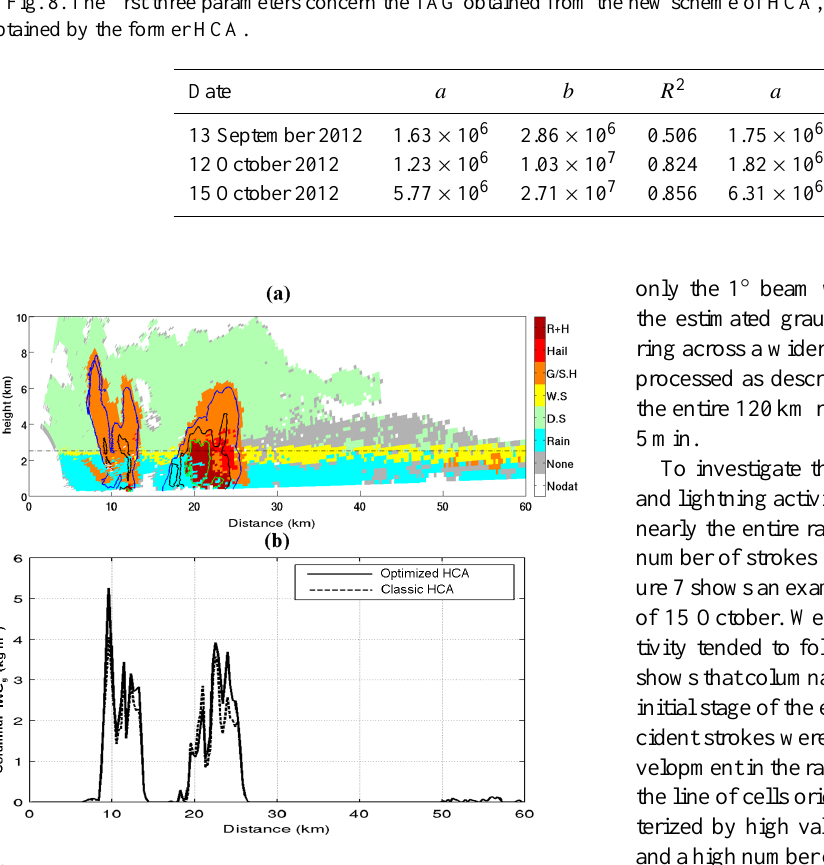
Figure 6. Polar 55C RHI scan collected at 17:55UTC on 15 Octo- ber 2012 for the azimuth at 293 ◦ along the Sapienza site with resam- pled radar measurements at a 300m range resolution. (a) FL HCA optimized for graupel, with the color bar as follows: white denotes no data, gray denotes data that are not classified, light blue denotes rain, green denotes dry snow, yellow denotes wet snow, orange de- notes graupel and small hail, red denotes hail, and dark red denotes a hail/rain mix. The Z h contours at 40dBZ (blue solid line), 50dBZ (black solid line), and 55dBZ (green solid line) are superimposed. The black dashed-dotted line shows the 0 ◦ C level. (b) Columnar IWC g corresponding to the RHI obtained from the HCA optimized for graupel (black solid line) and from the classical HCA (black dashed